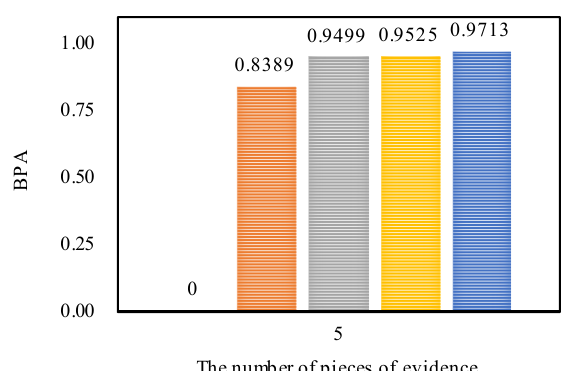
Figure 2. The comparisons of target a ’s BPA in terms of different